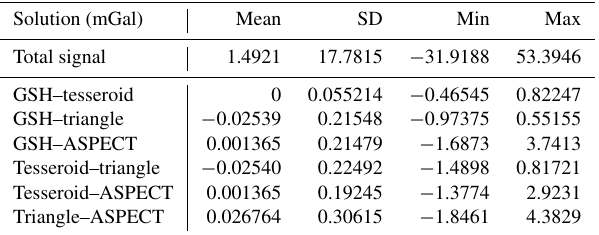
Table 2. Statistical results from shell test 2: a density shell of equal thickness is modelled with laterally varying density